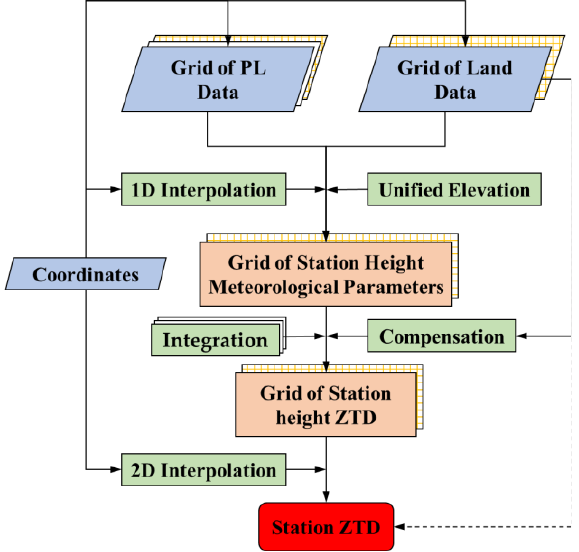
6 of 16 Figure 3. Schematic diagram of the ZTD integration method for reanalysis data. As the reanalysis data are provided by grid, it was necessary to interpolate the grid ZTD to the stations. The detailed process for inversion of station ZTD using meteorologi- cal reanalysis data is shown in Figure 4. Based on Figure 4 and the above equations, the specific steps for inversion of the station ZTD using reanalysis data are summarized as follows: (1) Original data acquisition: searching for meteorological pressure levels and land grid data for the four grid points nearest to the measurement site based on station coordi- nates (i.e., longitude and latitude). (2) Unified elevation system: converting the geopotential height of the meteorological data to GNSS geodetic height plus geoid height, which can be derived from GPT3 [20]. (3) Obtaining meteorological parameters for the station height grid: the two types of meteorological data acquired in step 1 are interpolated to the station height based on 1D interpolation. (4) Obtaining the grid ZTD of station height: the ZTD of each grid point is calculated according to Equations (1 – 9). The surface data can be brought into Equations (8 – 9) to give direct access to the grid ZTD, but this was not covered in this paper. (5) Gaining the station ZTD: Based on the coordinates and step 4, calculating the sta- tion ZTD using 2D interpolation. The interpolation method used in this paper was inverse distance weighted (IDW) with the following equations: 𝐷 𝑖 = √(𝐿 − 𝐿 𝑖 ) 2 + (𝜑 − 𝜑 𝑖 ) 2